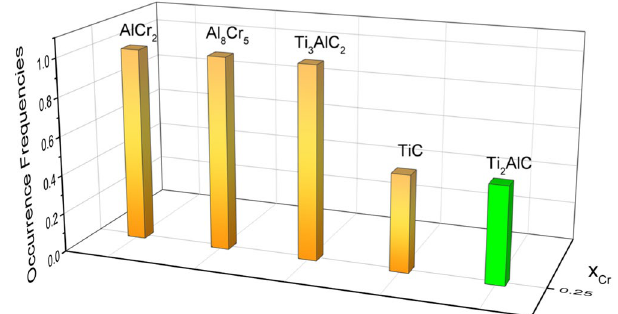
Figure 3. Occurrence frequencies of stable phases with Al and C ratios varying between 0.95–1.05 at 1300 °C. Here, it can be seen that all experimentally observed phases can be